Question: Author a descriptive caption for the visualization shown.
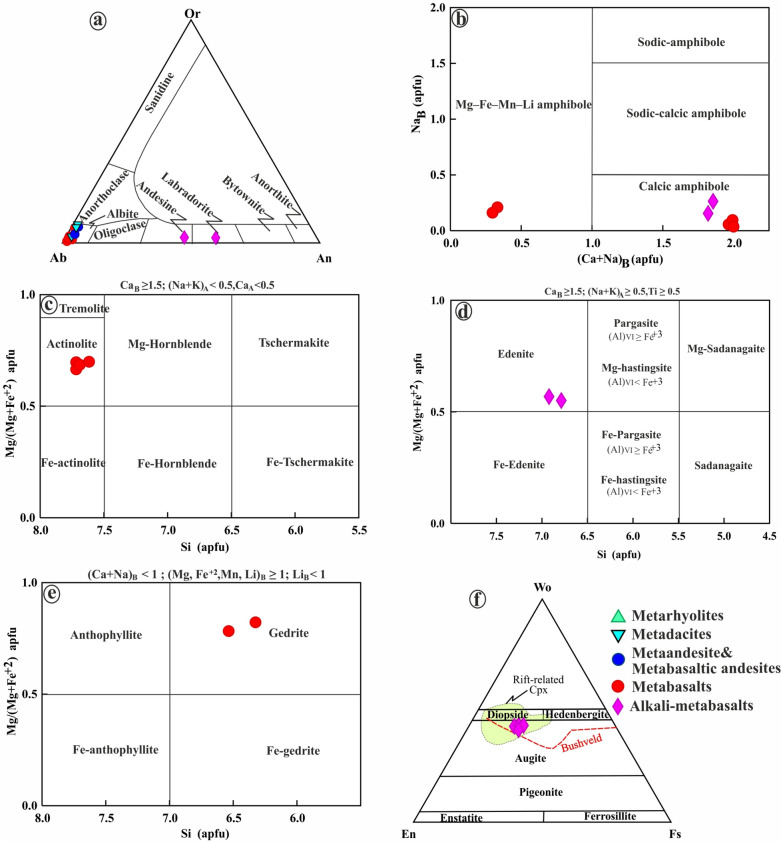
Answer: Mineral chemistry of plagioclase and amphibole minerals from the WRAM. ( a ) Ab‒An‒Or ternary classification diagram of plagioclase 83 , ( b ) (Ca + Na) B vs Na B classification diagram of amphibole types 84 , ( c ), ( d ) Si vs Mg/(Mg + Fe 2+ ) classification diagrams of calcic amphiboles, respectively 84 , ( e ) Si vs. Mg/(Mg + Fe 2+ ) classification diagrams of magnesian amphiboles 84 , ( f ) Enstatite (En)-Ferrosilite (Fs)-Wollastonite(Wo) ternary diagram of clinopyroxene 85 . The rift-related Cpx polygon is after Muravyeva, et al. 86 , Li, et al. 87 , and Zhu, et al. 88 ; while the Bushveld line is after Atkins 89 . This figure is created by the Igpet 2010 software ( https://www.rockware.com/product/igpet/ ).